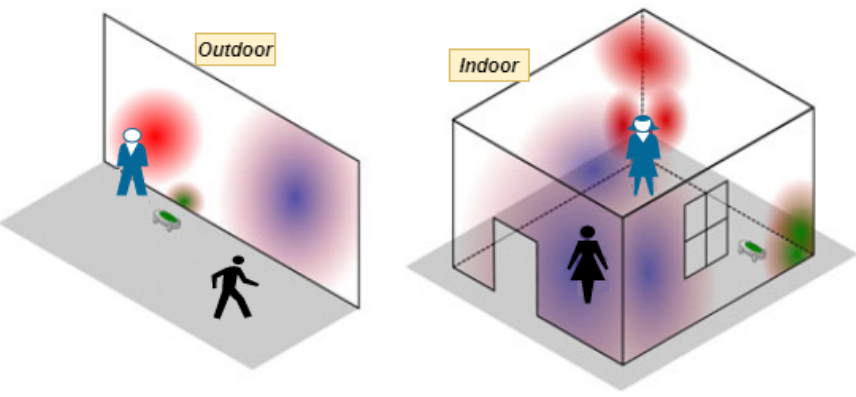
Figure 6. IRS-assisted THz localization.